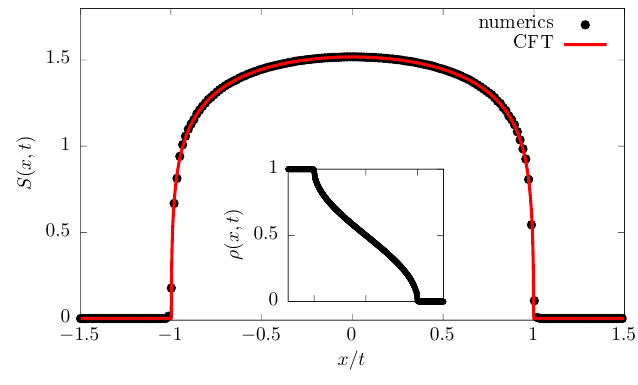
Figure 3: von Neumann entanglement entropy as a function of x / t after a quench from the domain wall initial state. The numerical simulations are performed using a finite system with 4096 sites. Data for t = 512 are reported (black circles) and compared to our analytical prediction (red line): the agreement is nearly perfect. Inset: corresponding density profile ρ ( x , t ) after the